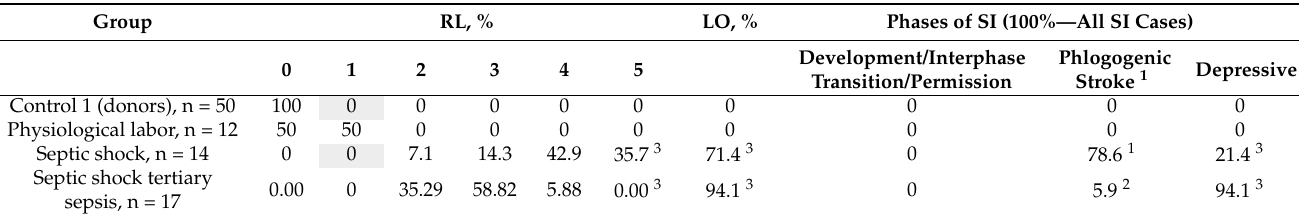
Table 7. The rates of occurrence of acute SI phases, and registration of lethal outcomes in the comparison groups